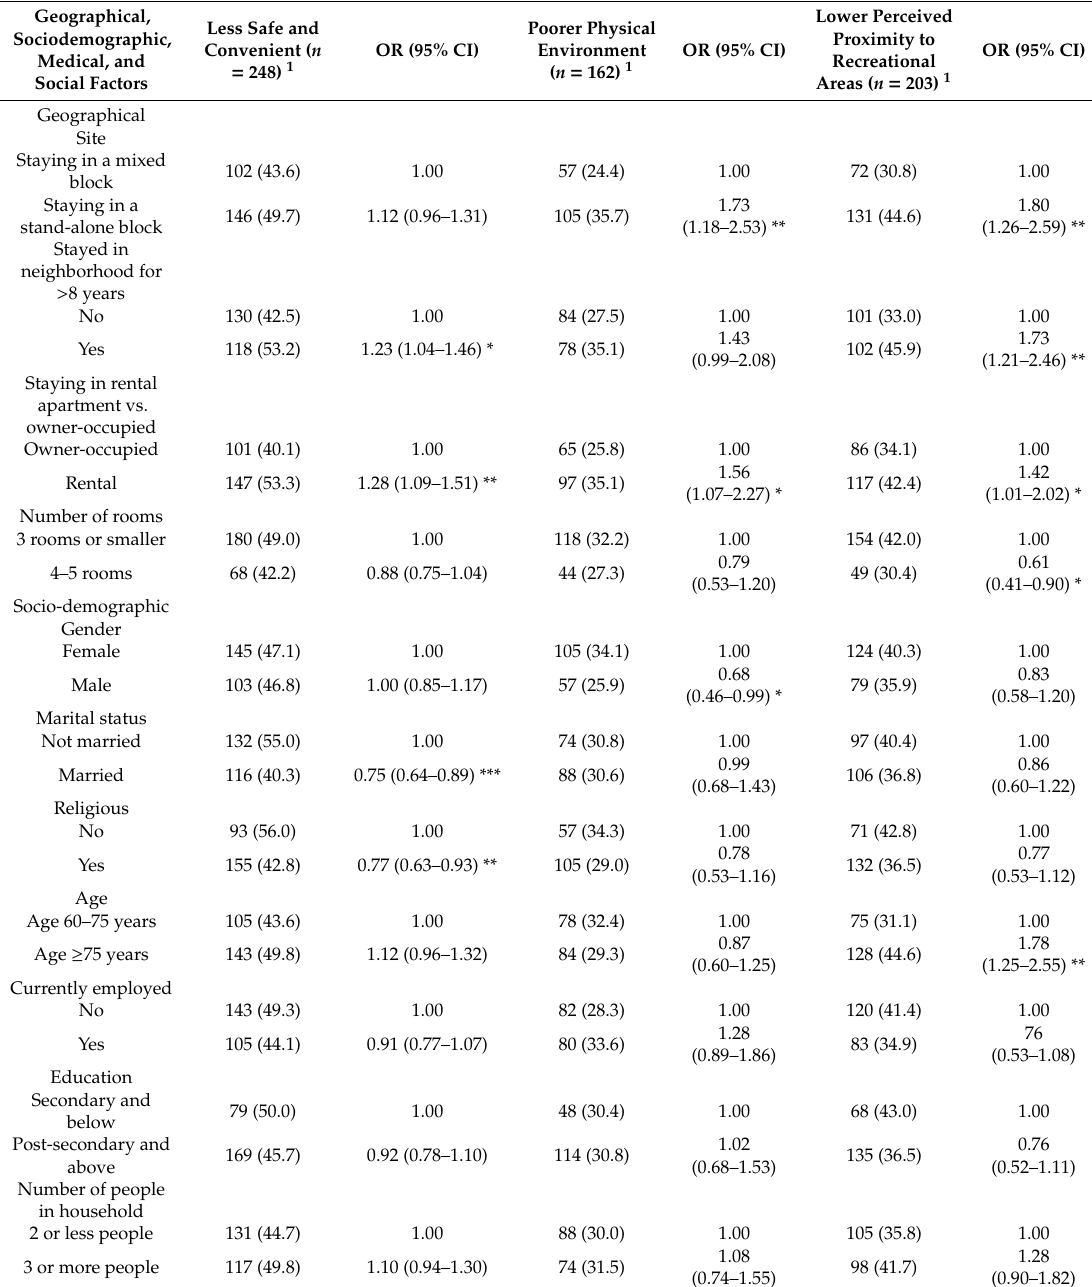
Table 2. Associations between perceived neighborhood safety and convenience, perceived physical environment, and perceived proximity to recreational areas, amongst residents in two public housing precincts in Singapore, on univariate analysis ( n =